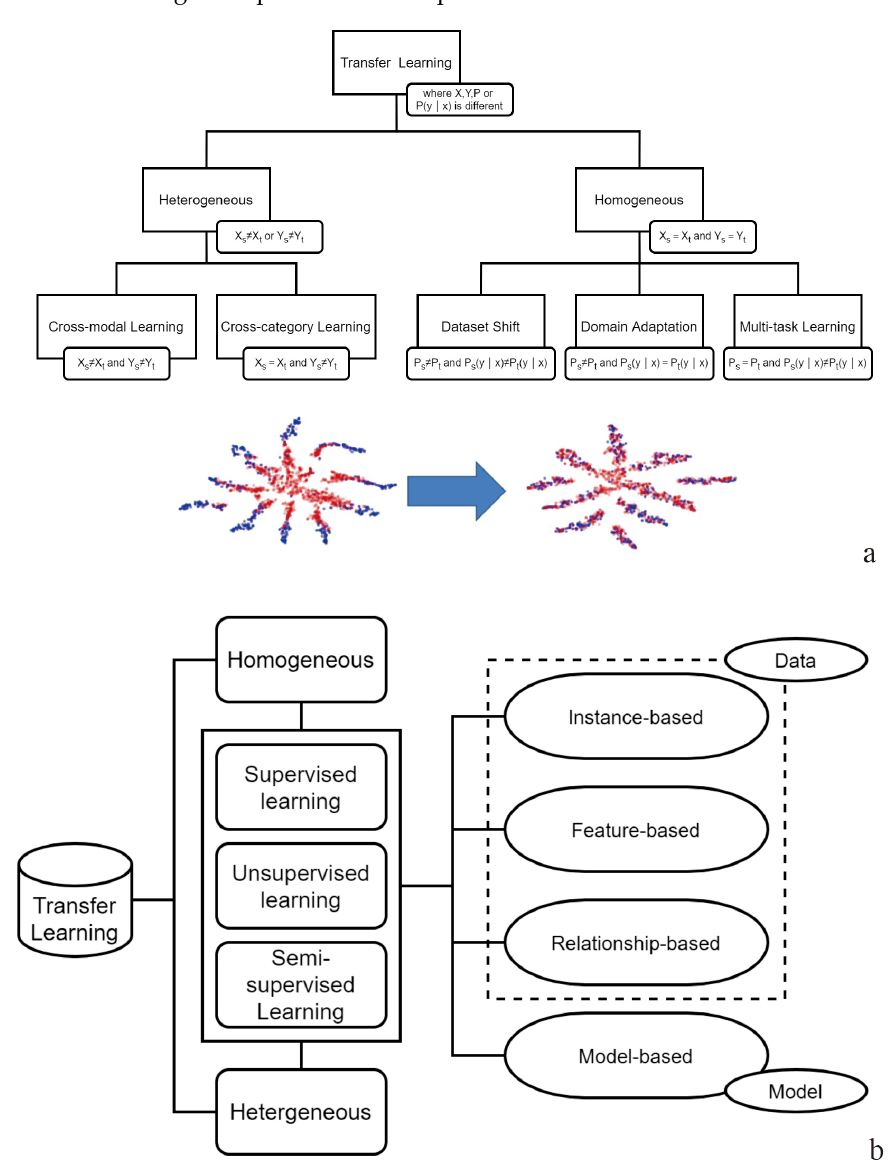
Figure 8. Classification of transfer learning ( a ) based on characteristic space and label space and ( b ) based on the transfer learning method.